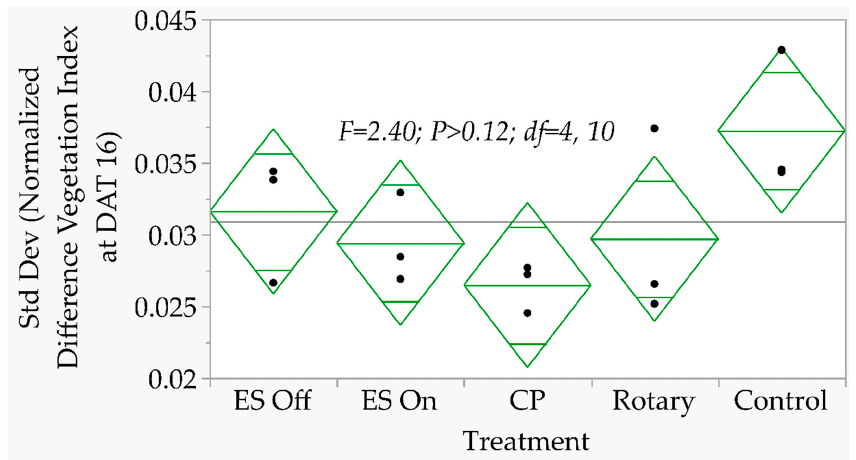
Figure 6. Mean standard deviation of NDVI at DAT 16 averaged by replication and treatment. The middle line within each diamond is the group mean with the vertical point forming the 95% CIs. The center line is the grand mean for the response variable. The treatments described on the X -axis are electrostatically charged off (ES Off) and charged on (ES On) nozzles, the conventional hydraulic (CP) nozzle, and the rotary atomizer (Rotary) nozzle, compared with the Control.